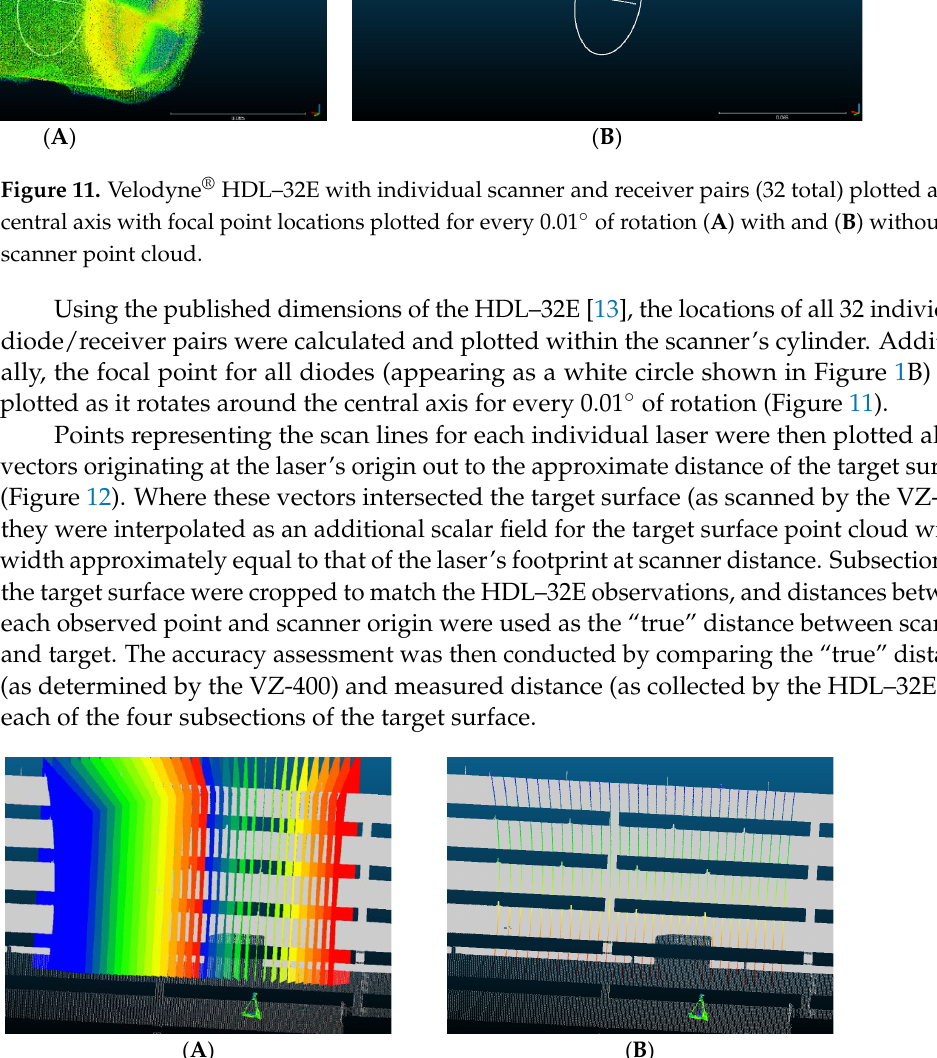
Figure 12. Projection of Velodyne ® HDL–32E scan lines in ( A ) the Riegl ® VZ-400 point clouds and ( B ) their interpolation as an additional scalar field on the target surface. Mid–40